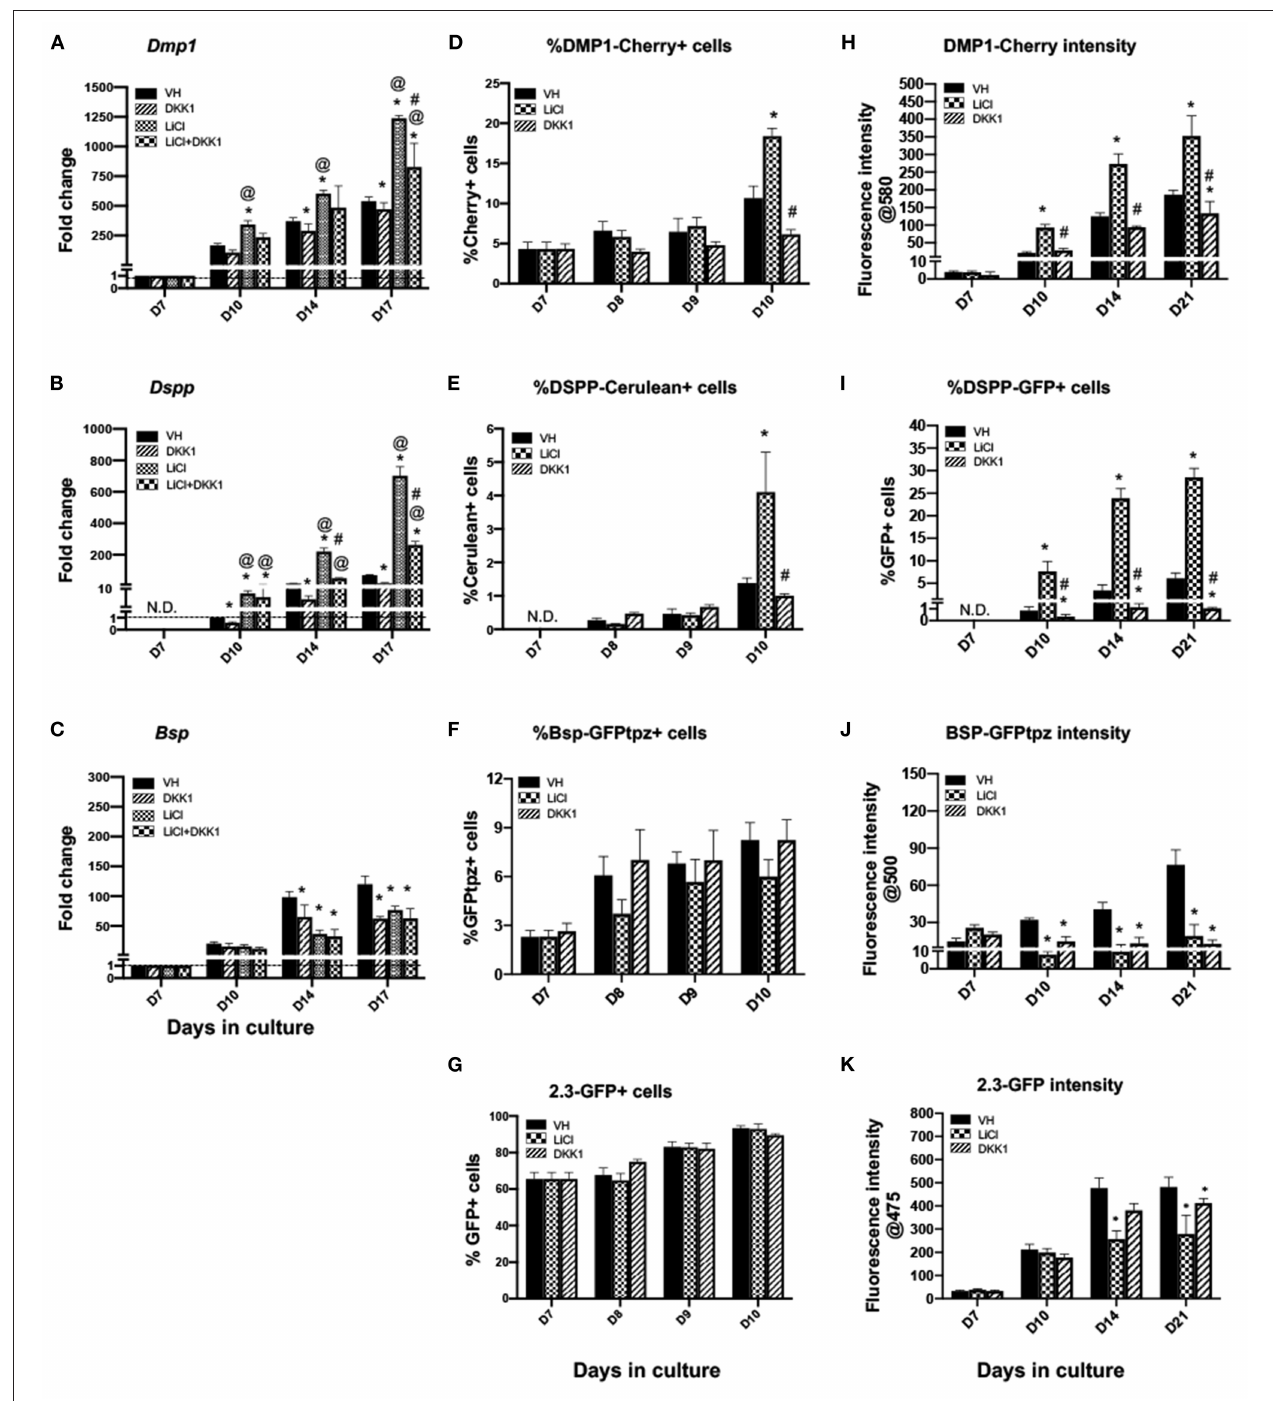
FIGURE 5 | Effects of late exposure to LiCl on the expression of differentiation markers and tissue- and stage-specific reporters in primary dental pulp cultures.Primary pulp cultures were treated late from days 7 to 21 with VH (0.1% BSA), LiCl (10mM), DKK1 (50ng/ml) or simultaneous LiCl (10mM) and DKK1 (50ng/ml). (A–C) Graphs showing changes in the expression of Dmp1, Dspp, and Bsp in cultures treated with VH, LiCl, and DKK1 alone or with simultaneous LiCl. Late exposure to LiCl showed significant increases in Dmp1 (A) and Dspp (B) at days 10–17, which were significantly decreased by DKK1 treatment alone. DKK1 treatment also significantly decreased the LiCl-induced increases in Dmp1 and Dspp to levels higher than control. However, late LiCl treatment, as well as DKK1 treatment, significantly decreased Bsp expression. The LiCl-induced decreases were not reversed by DKK1 (C) . Expression of Dmp1 and Bsp was normalized to day 7 and Dspp was normalized to day 10 of the VH-treated cultures, which is arbitrarily set to 1 and is indicated by the dashed line. (D–G) Graphs showing